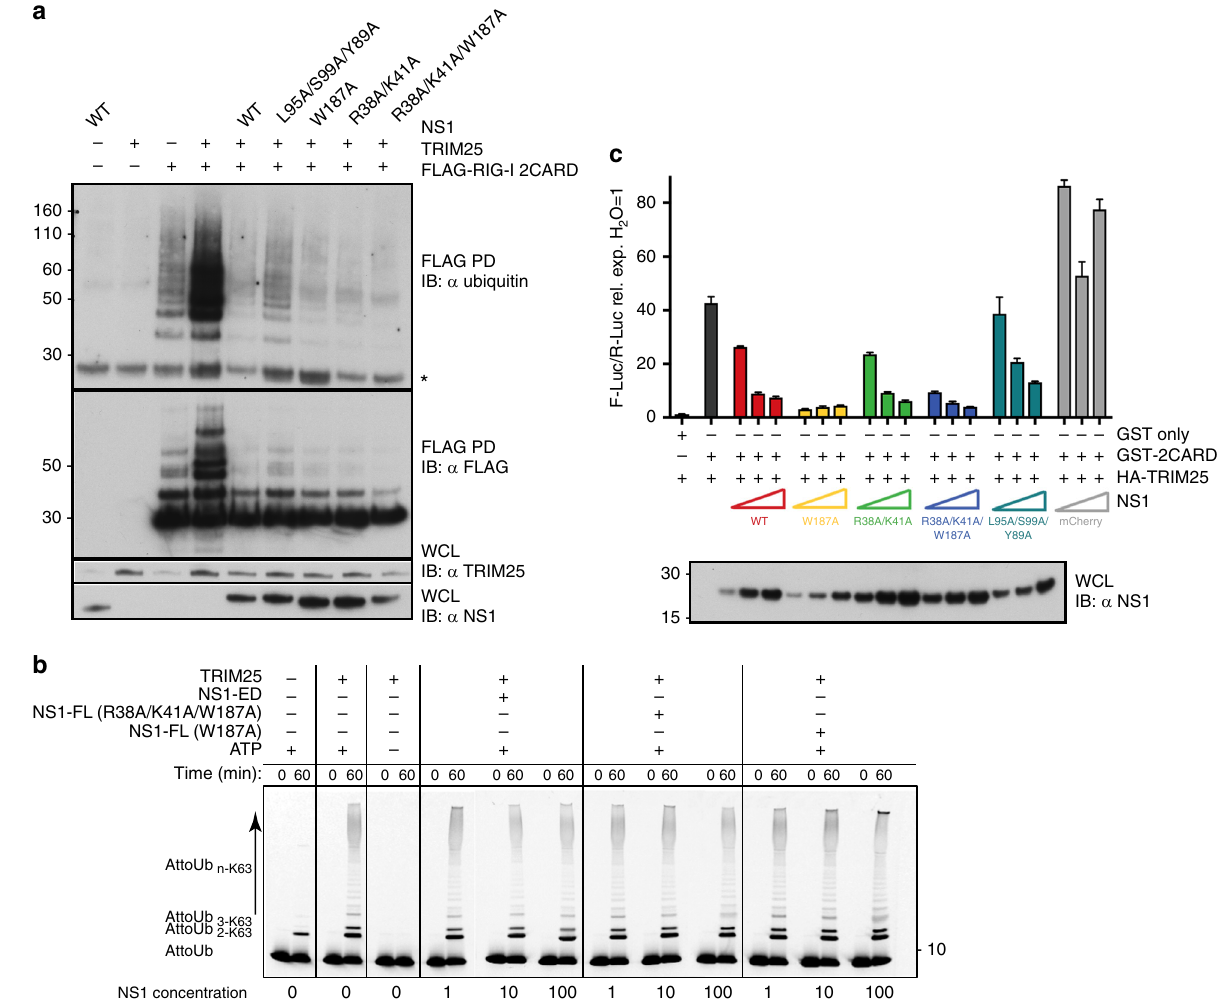
Fig. 5 Inhibition of TRIM25-mediated RIG-I ubiquitination and signalling by NS1. a Effect of NS1 and mutants on the ubiquitination of 3FLAG-RIG-I-2CARD by TRIM25 in HEK293T cells. 3FLAG-RIG-I-2CARD, TRIM25 and NS1 were co-transfected into HEK293T cells and WCLs were subjected to IP with anti- FLAG beads and immunoblotted with α -ubiquitin and α -FLAG antibodies. The asterisk indicates an unspeci fi c band. b In vitro ubiquitination assays with UBE2N/UBE2V1 and TRIM25-FL in the absence or presence of increasing amounts of NS1 supplemented with fl uorescent AttoUb. Assays were carried out with NS1-ED or NS1-FL (R38A/K41A/W187A or W187A) and the reaction was monitored over 60 min. Gels were scanned with a Typhoon FLA 9500 scanner and the fl uorescence converted to black and white. c 3FLAG-RIG-I-2CARD, TRIM25, and increasing amounts of NS1 WT and mutants